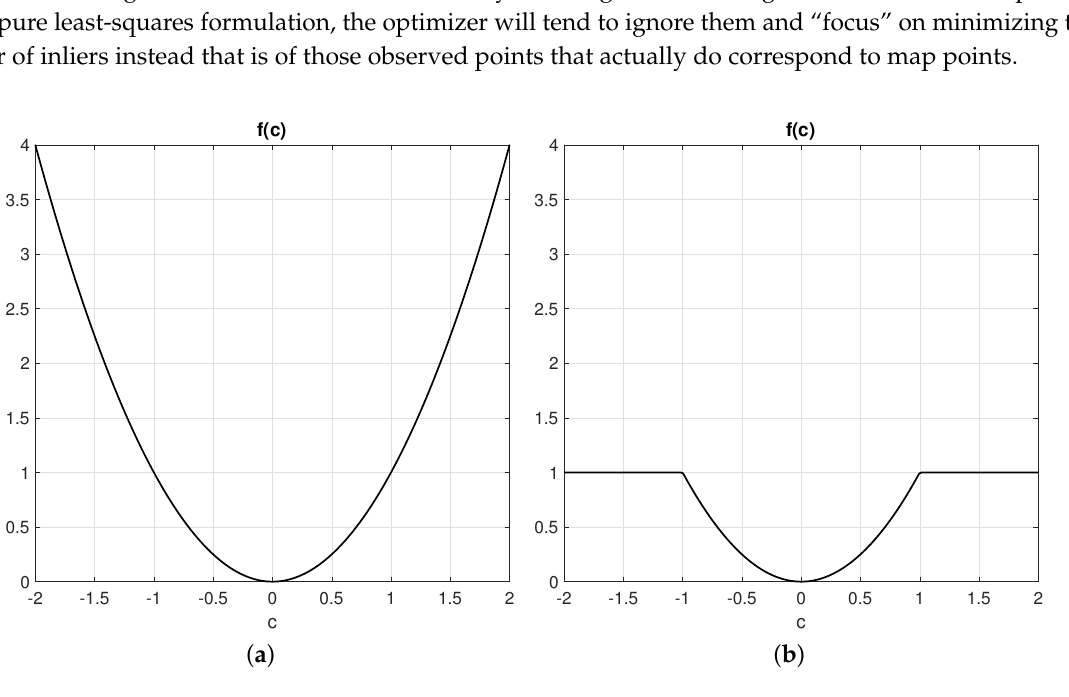
Figure 2. The cost function for regular least squares ( a ) and for truncated least squares ( b ) with θ = 1. The latter significantly reduces the associated cost of outliers, thus removing their contribution to the actual cost function to be